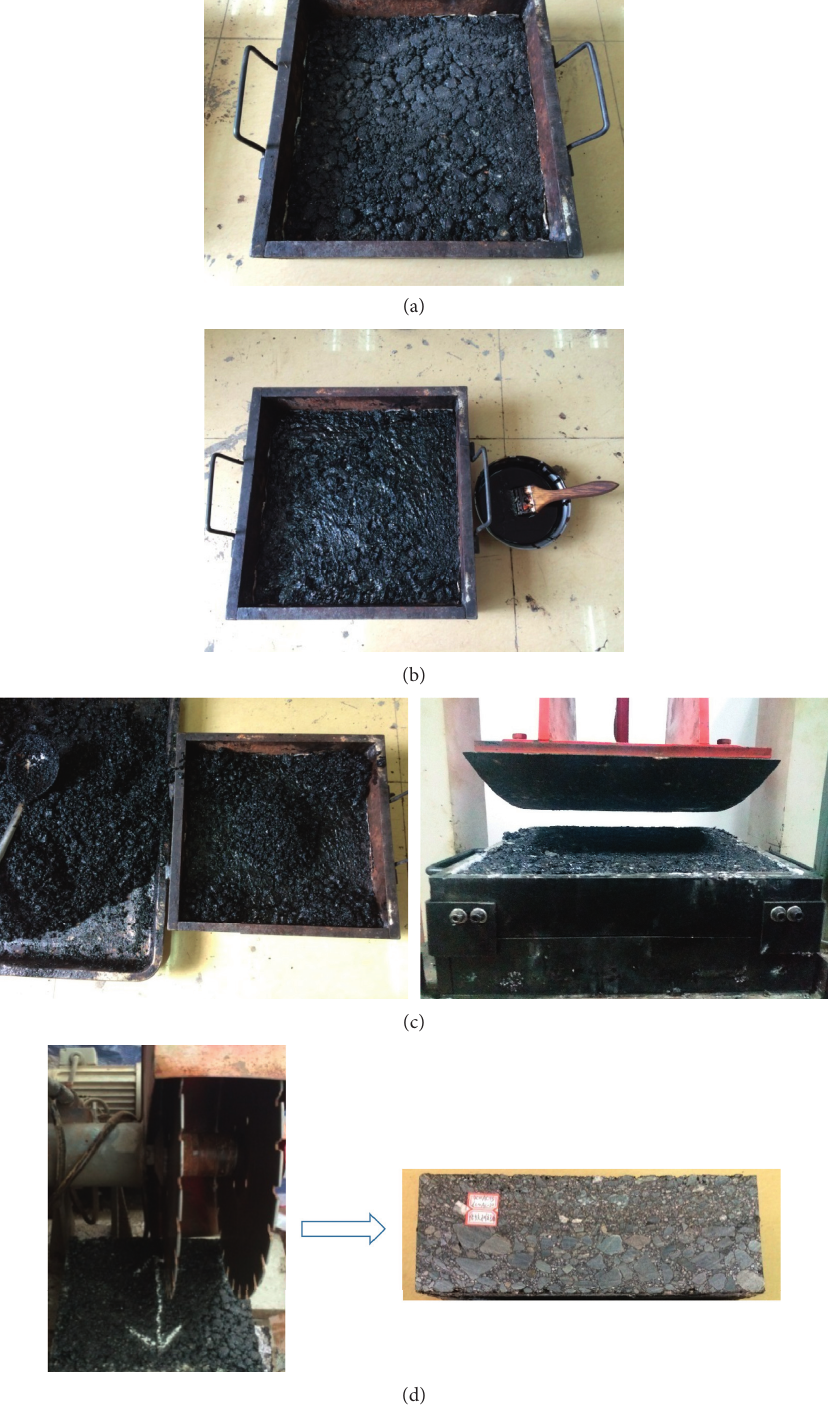
Figure 1: Traditional paved beam test specimen preparation process. (a) Mold the bottom layer cut board. (b) Spray the sticky layer oil. (c) Mold the surface layer cut board. (d) Produce the beam